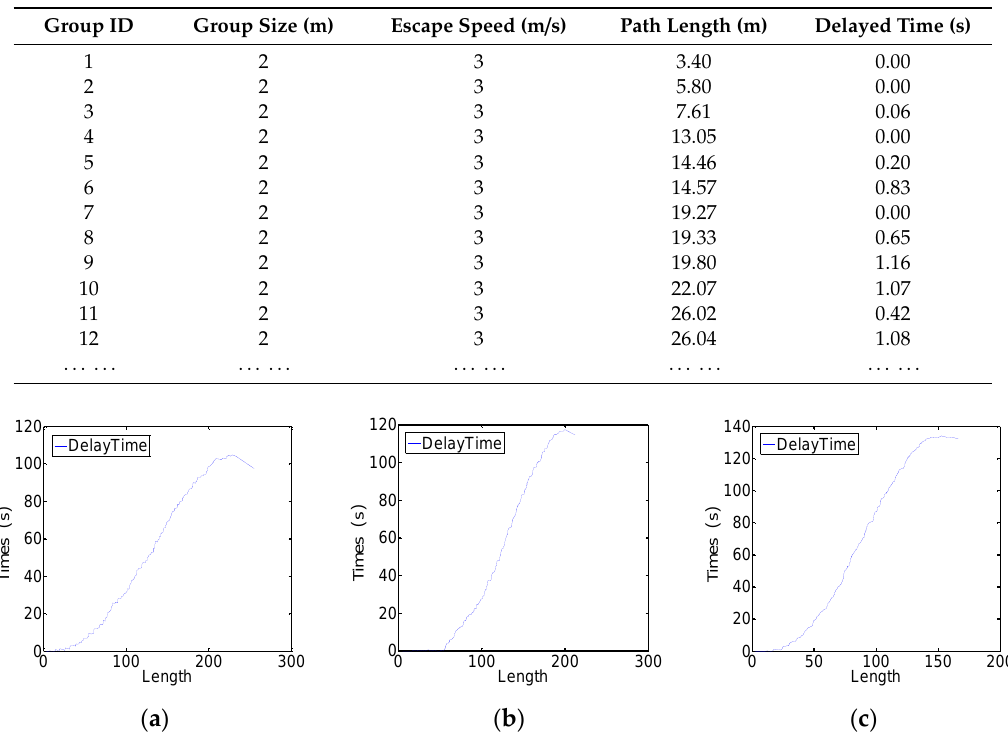
Figure 17. The relationship of the evacuation path length and the delayed departure time of all groups in each zone when evacuation density is low. ( a ) Zone E1; ( b ) Zone E2; ( c ) Zone